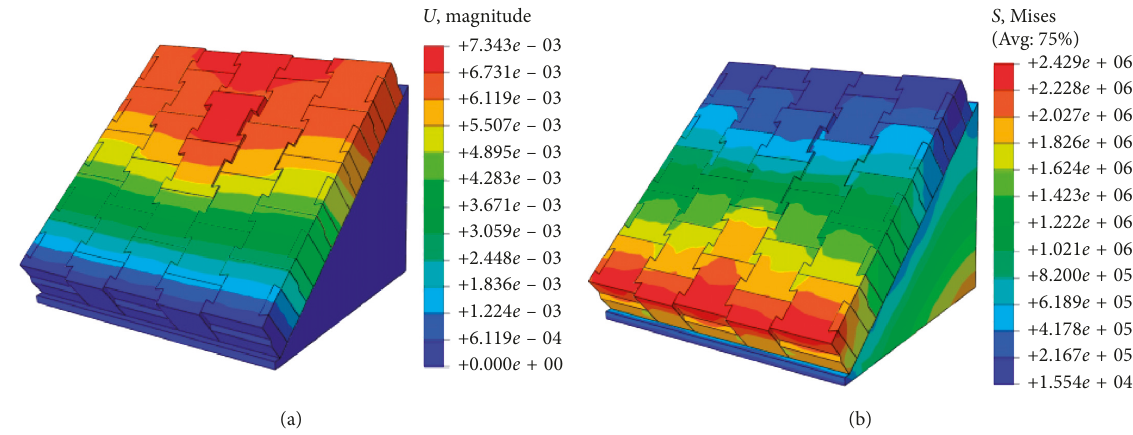
Figure 14: Simulation results of H-type gravity mutual-aid block revetment. (a) Equivalent displacement nephogram. (b) Equivalent stress nephogram.